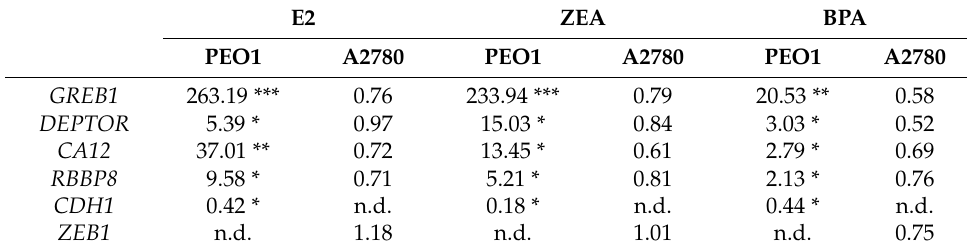
Table 1. Relative expression ratio of GREB1 , DEPTOR , CA12 , RBBP8 and CDH1 in response to estrogen treatments in the PEO1 and A2780 cell lines. Total RNA was isolated from the cells 24 h after E2, ZEA and BPA treatments. Relative expression ratio was calculated relative to the expression value of their respective mRNAs in the non-treated control (1). Notes: Ratio > 1 indicates upregulation relative to the non-treated control. Ratio < 1 indicates downregulation relative to the non-treated control. Significance was determined between the ∆ CT values of treated and non-treated samples: * p < 0.05; ** p < 0.01; *** p < 0.001. n.d.-not detectable.